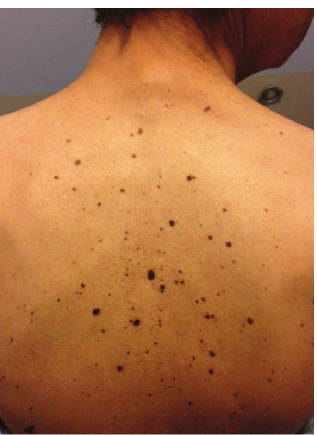
Figure 2: The skin lesions are seen distributed in a characteristic “raindrop” or “splash” pattern on the back.